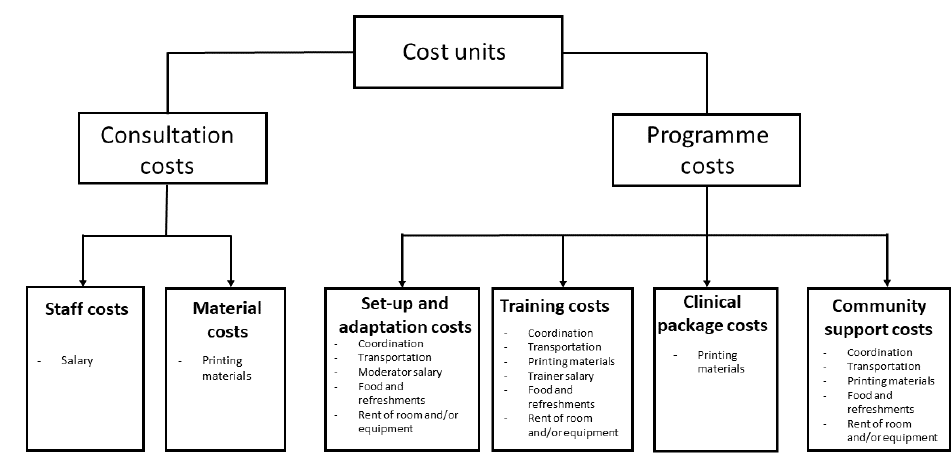
Figure 2. Cost units identified, measured, and valued in the SCALA project.